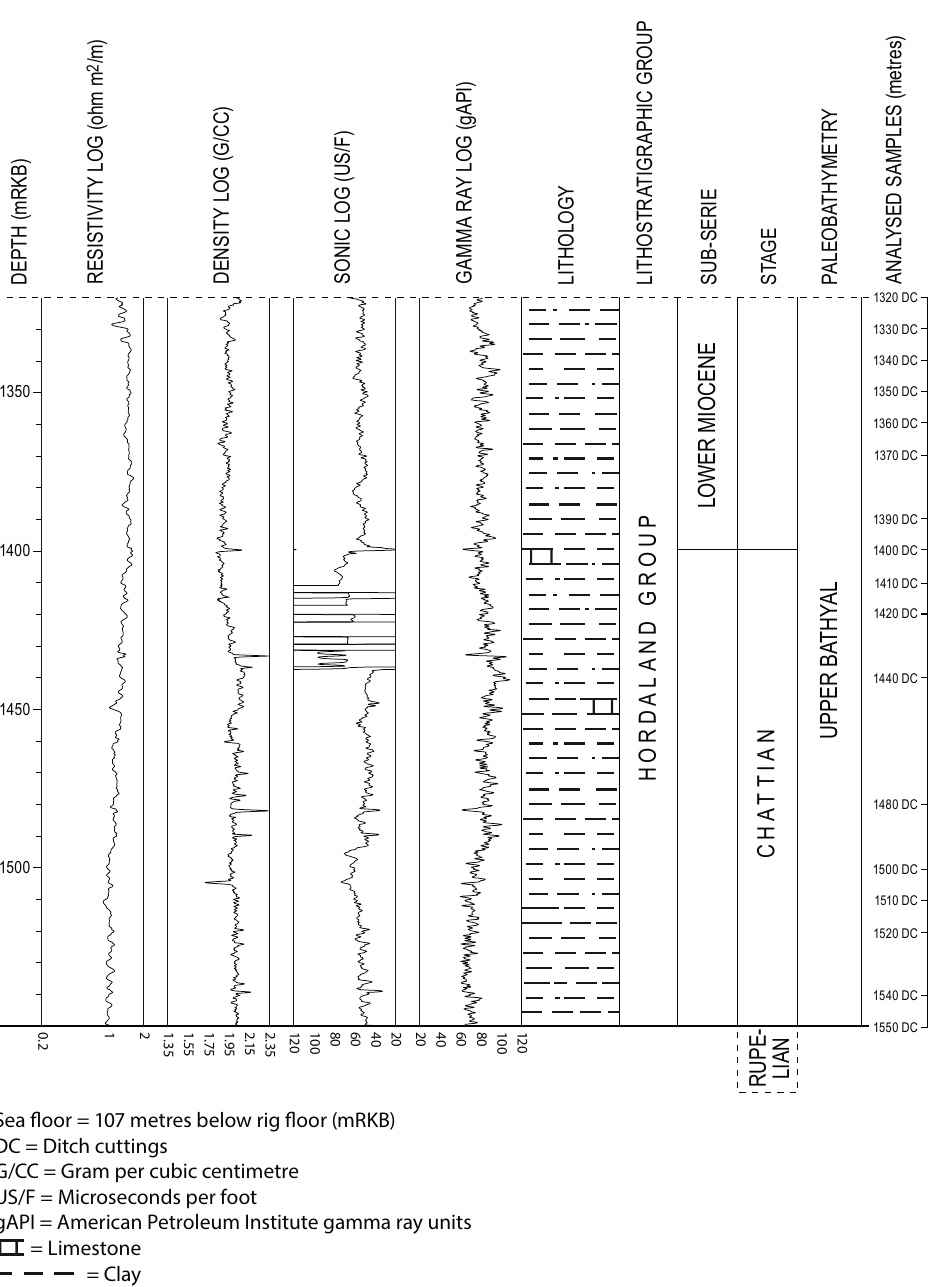
Figure 42. Well summary figure including resistivity log, density log, sonic log, gamma-ray log, lithology, litho- stratigraphic unit, sub-series, stage, paleobathymetry and analysed samples for the lower part of the investigated sequence in well 15/9–13 (Chattian to lower Miocene; modified after Eidvin et al.,